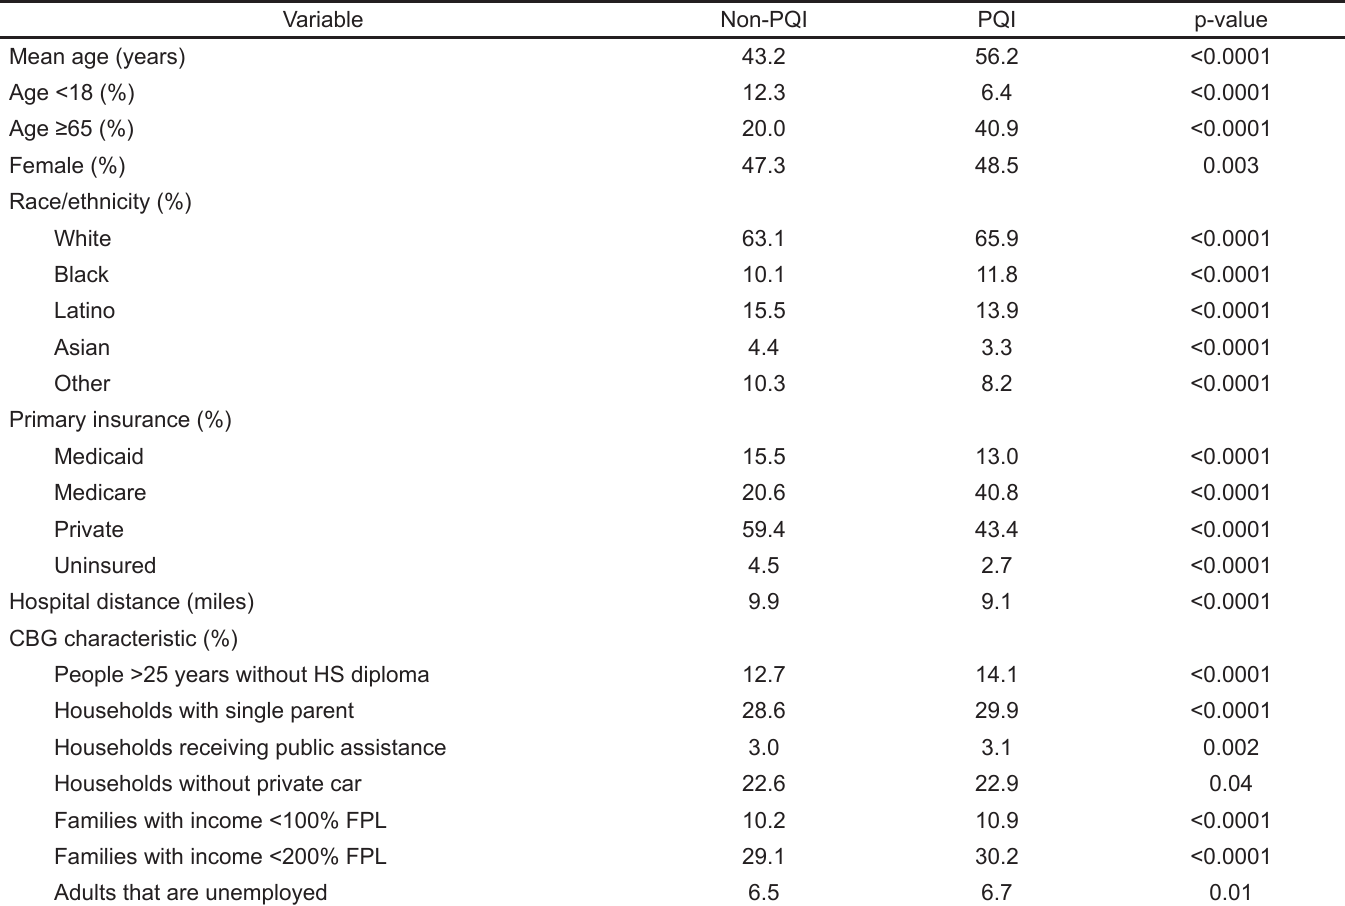
Table 1. Comparison of demographic and neighborhood-level socioeconomic variables among Prevention Quality Indicators (PQI) and non-PQI